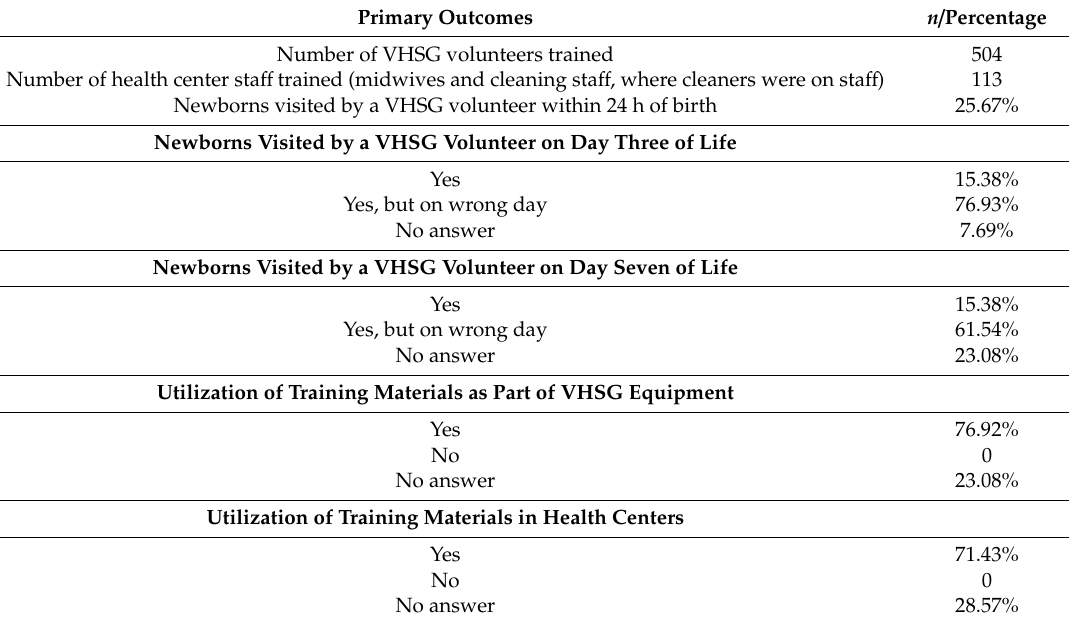
Table 4. Process evaluation indicators and